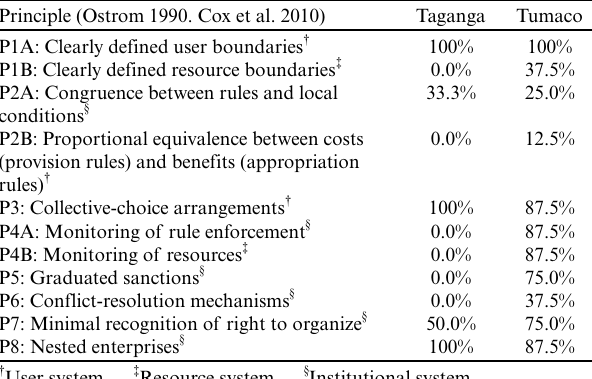
Table 4. Prioritization of the principles for success in Taganga and Tumaco calculated as the percentage of participants who believe that each principle should be prioritized (“red” light).